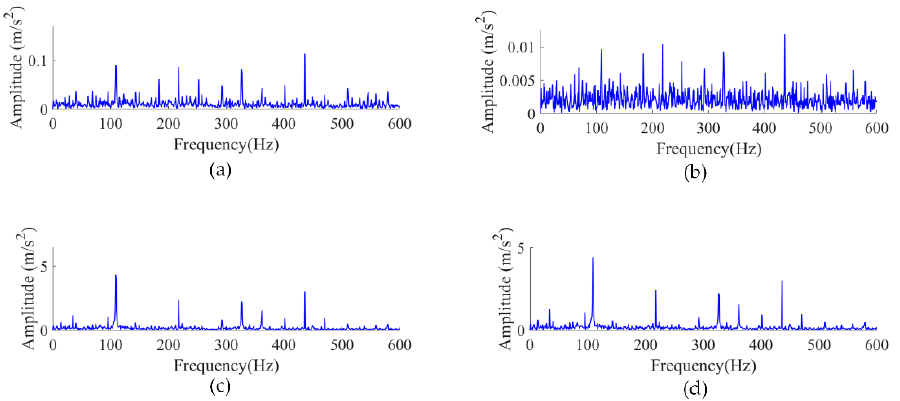
Figure 11. Denoising the 100th minute signals envelope spectra of 4 different methods. ( a ) L1-kurtosis, ( b ) RSVD, ( c ) VMD, and ( d ) SRSVD.